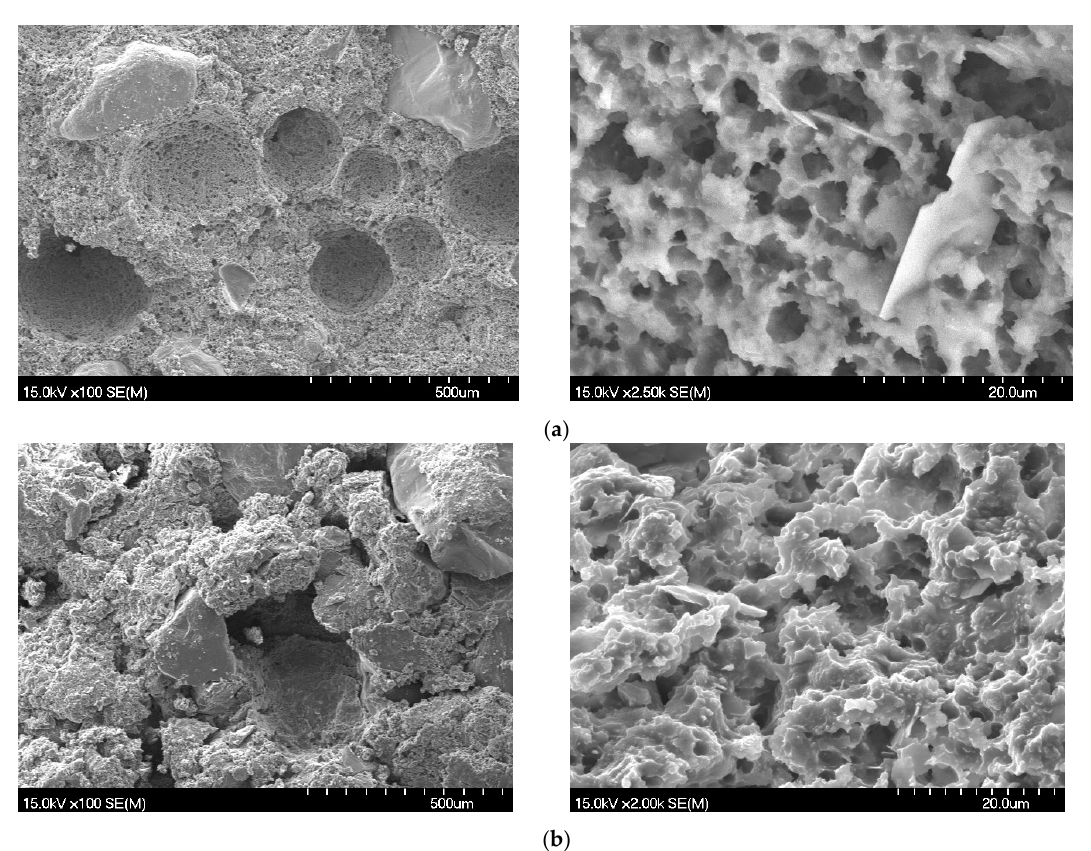
Figure 8. SEM photograph of the CA mortar ( a ) under the standard curing condition and ( b ) after the fatigue test at 50 Hz but at the same total curing age.